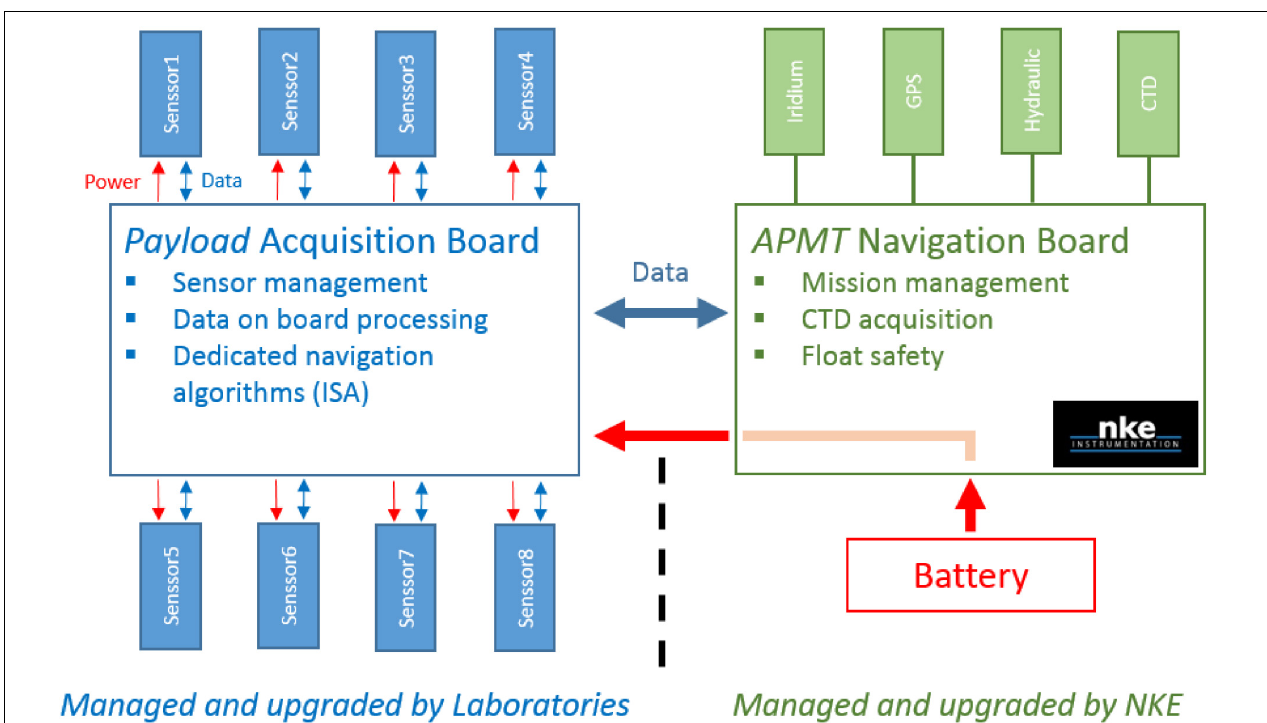
FIGURE 4 | Schematic representation of the two-board system of the new CTS5- Payload